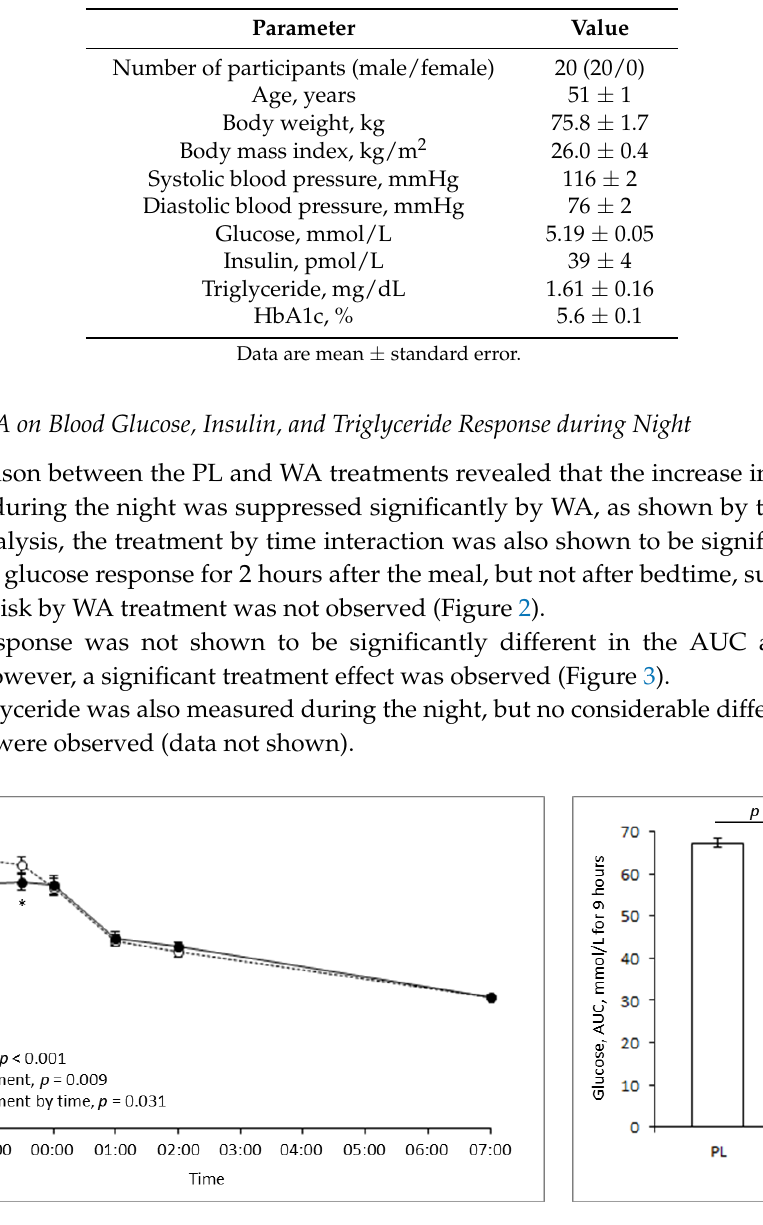
Figure 2. Changes in the blood glucose level during the night following the placebo (PL) (broken line, n = 20) and wheat albumin (WA) treatments (solid line, n = 20). ( Left ) Changes in the blood glucose response. ( Right ) The AUC of the blood glucose level for 9 h from 22:00 hour to 7:00 hour. Data are the mean ± standard error. Significant differences between the treatments: * p < 0.05, *** p < 0.001.